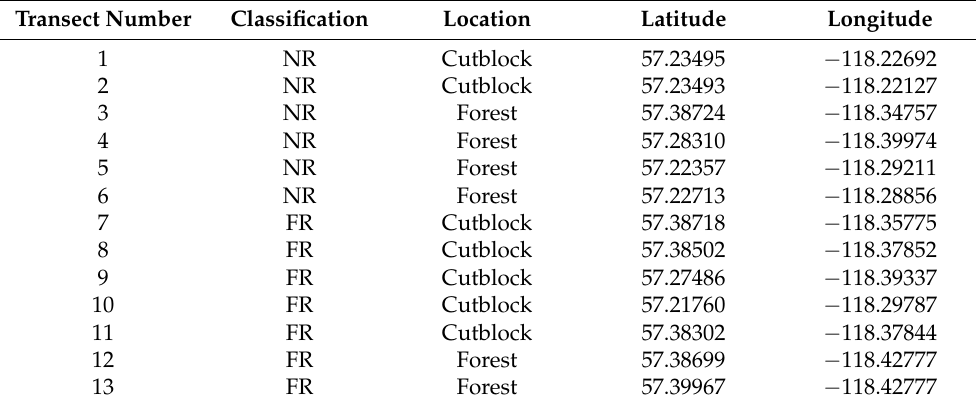
Table 1. Transect classifications (Not Recovered (NR), Fractionally Recovered (FR), and Recovered (R)) and